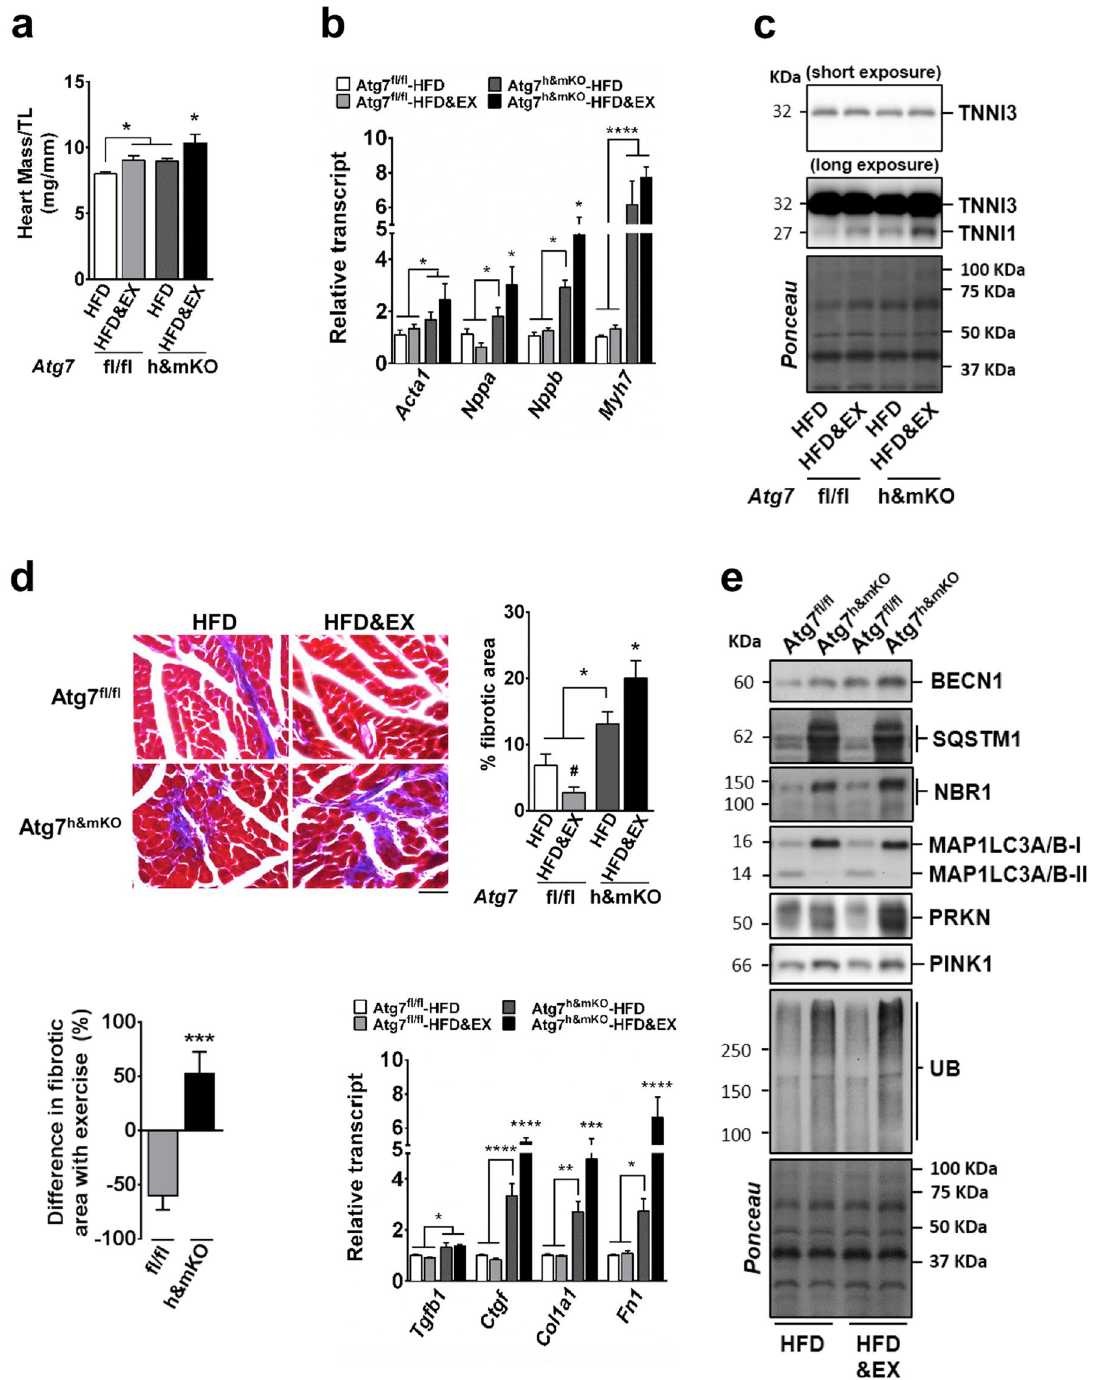
Figure 5. Exercise causes unfavourable cardiac remodelling in Atg7 h&mKO mice. ( a ) Heart mass normalized to tibia length (TL) (n = 6–11). ( b ) mRNA analysis of foetal genes (n = 5–8). ( c ) Immunoblot representative images of the mean value for cardiac troponin I3 (TNNI3) and skeletal muscle TNNI1 (n = 4). ( d ) Representative micrographs of Masson’s trichrome stain showing fibrosis in left ventricle sections (Scale bar = 100 μ m), and quantification of fibrotic area represented as a percentage of total area, quantification of the difference in fibrotic area with exercise training for each genotype, and mRNA analysis of genes involved in fibrosis (n = 5–8). ( e ) Immunoblot representative images of the mean value for select autophagy, mitophagy and ubiquitinated proteins (n = 4). Full-length blots are presented in Supplementary Fig. S6. * P < 0.05, ** P < 0.01, *** P < 0.001 and **** P < 0.001 in comparison to all other groups, unless otherwise represented; # P < 0.05 in comparison to Atf7 fl/fl